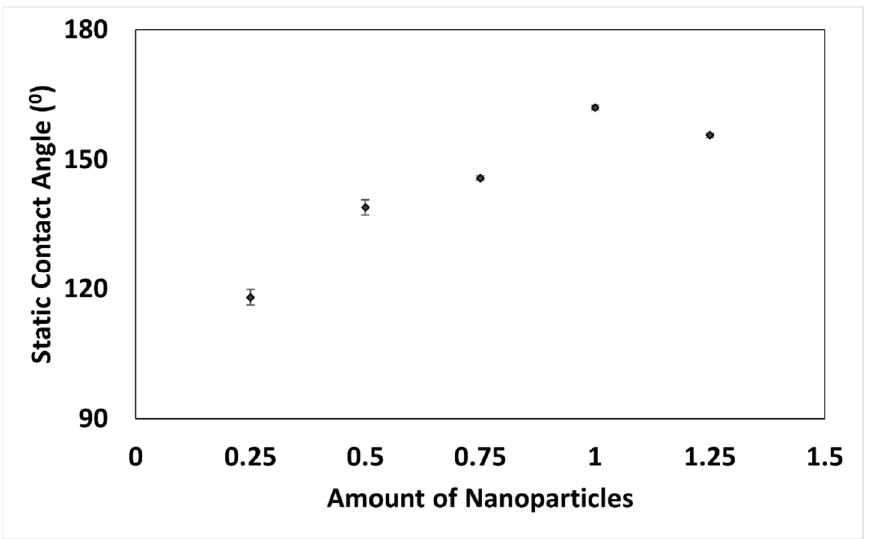
Figure 1. Variation in contact angle with respect to the amount of silica particles in 1 g of Epoxy.